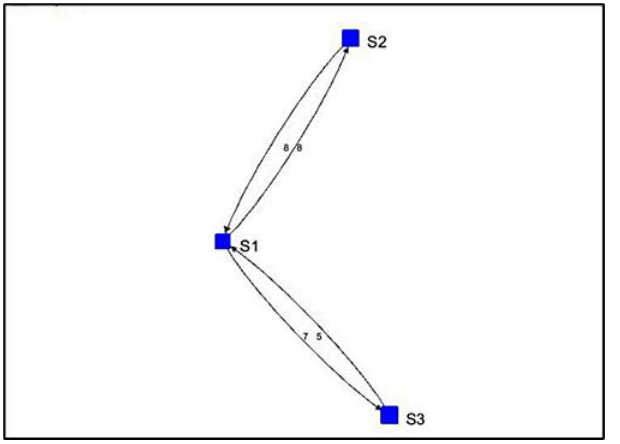
Figure 10. Algorithm 2 ’ s visualization of Path 1 vectors.